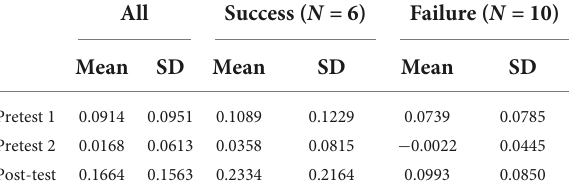
TABLE 6 Cerebral blood flow (ROI). All Success ( N = 6)